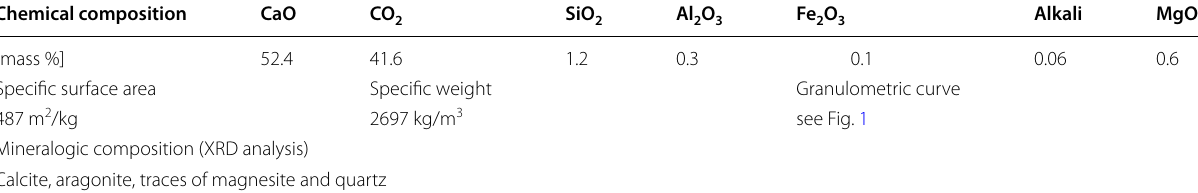
Table 3 Properties of the limestone VMV15-F